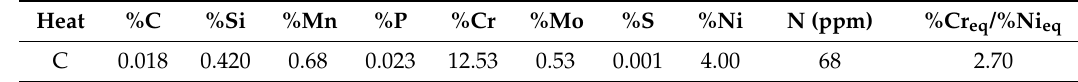
Table 4. Chemical composition of the alloy